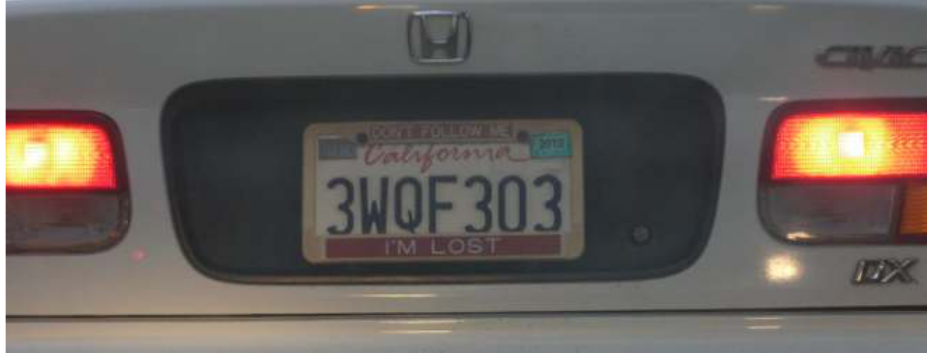
Figure 7: Humorous license plate: “I’m lost, error